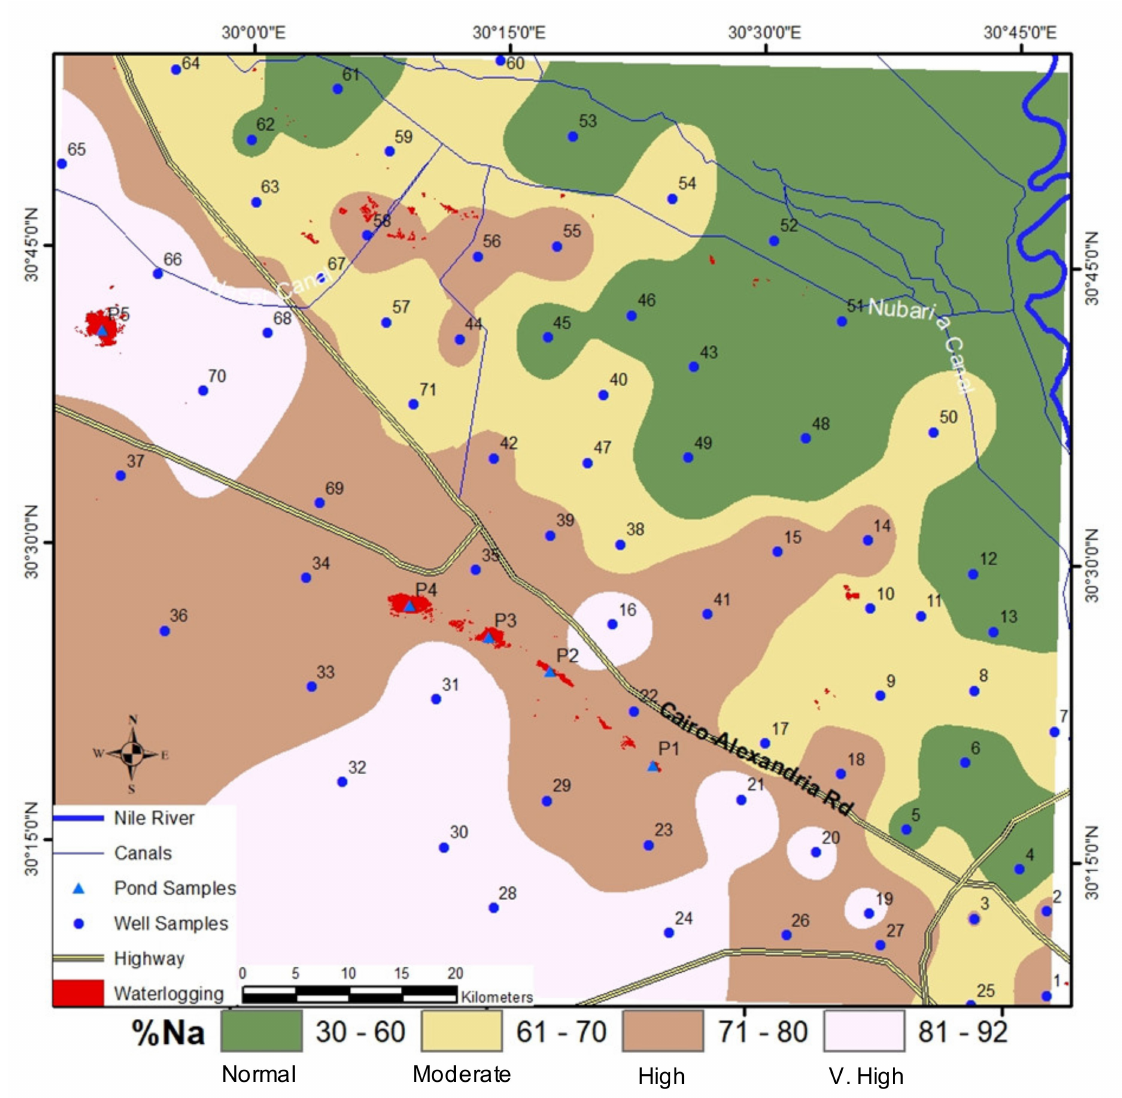
Figure 11. GIS IDW interpolation of sodium hazard based on the USSL classification of the soluble sodium percent